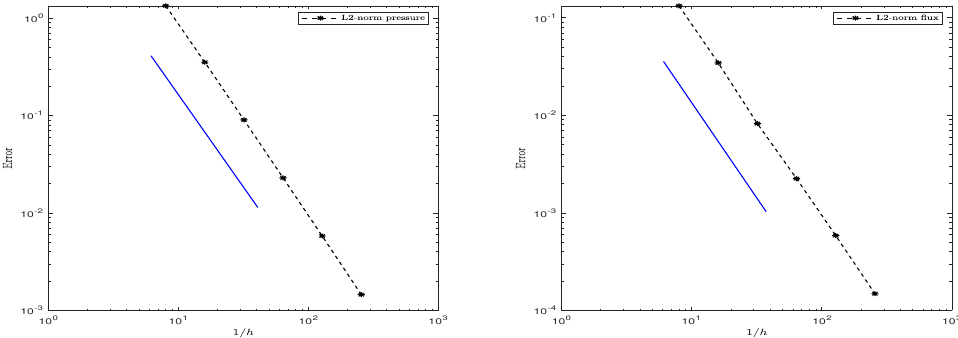
] versus 1/ h . The slope of the line is − 2. ( Right ): Plot of L 2 ( D h )